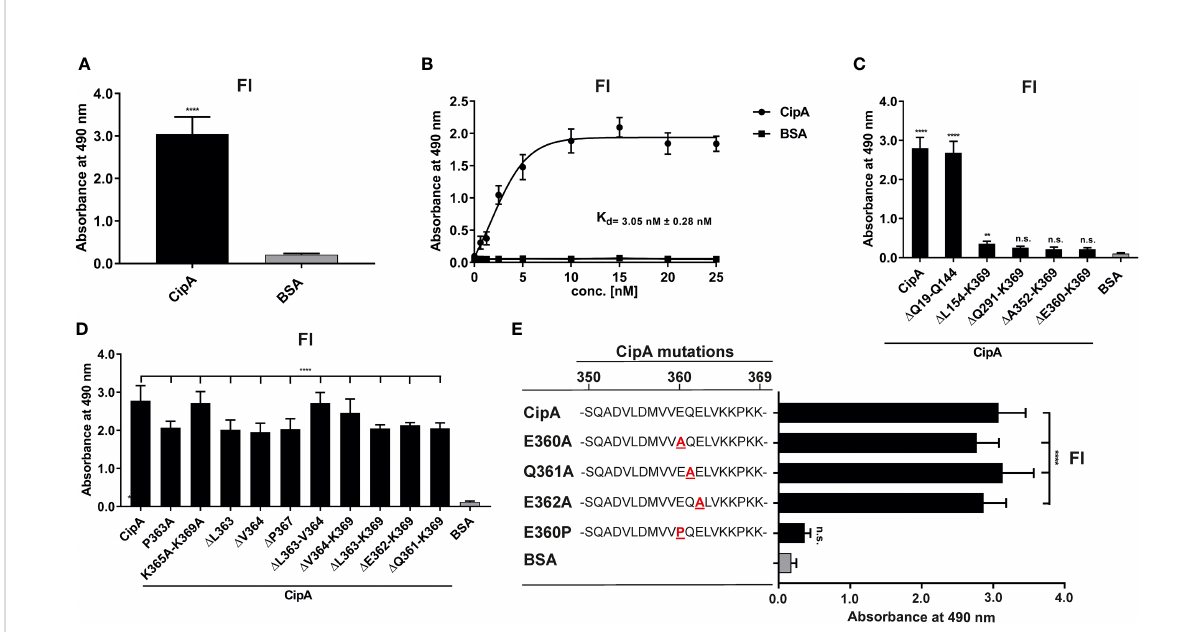
FIGURE 4 Interaction of CipA with FI. Protein binding of FI to CipA was measured by ELISA (A) . CipA-coated wells (5 ng/µl) were incubated with 5 ng/µl puri fi ed FI and protein complexes were detected using an anti-FI antibody (1:1,000). To assess statistical signi fi cance, one-way ANOVA with post-hoc Bonferroni multiple comparison test (con fi dence interval = 95%) was performed. Data represent means and standard deviation of at least three different experiments, each conducted in at least triplicate. ****, p ≤ 0.0001. Dose-dependent binding of FI to CipA (B) . CipA (5 ng/ µl) immobilized was incubated with increasing concentrations (0 to 25 nM) of puri fi ed FI and dissociation constant was approximated via non- linear regression, using a one-site, speci fi c binding model. Data represent means and standard deviation of at least three different experiments, each conducted in triplicate. Detection of the FI-interacting region within CipA employing diverse CipA variants (C – E) . Microtiter plates coated with CipA and CipA variants (5 ng/µl) were incubated with FI (10 ng/µl) and binding was detected by an anti-Fi antibody (1:1,000). BSA was used as negative control in all assays. Data represent means and standard deviation of at least three different experiments, each conducted in triplicate. **, p ≤ 0.05, ****, p ≤ 0.0001, n.s., no statistical signi fi cance, one-way ANOVA with post-hoc Bonferroni multiple comparison test (con fi dence interval =